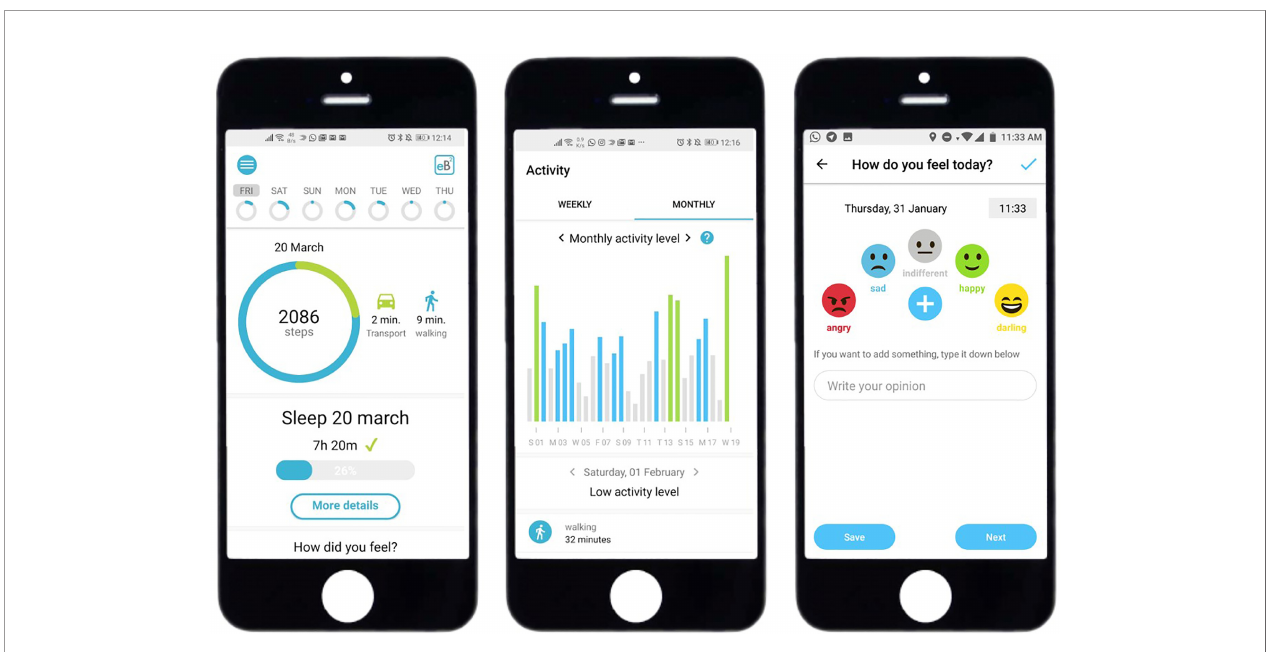
FIGURE 3 | Diagram of the main mobile app